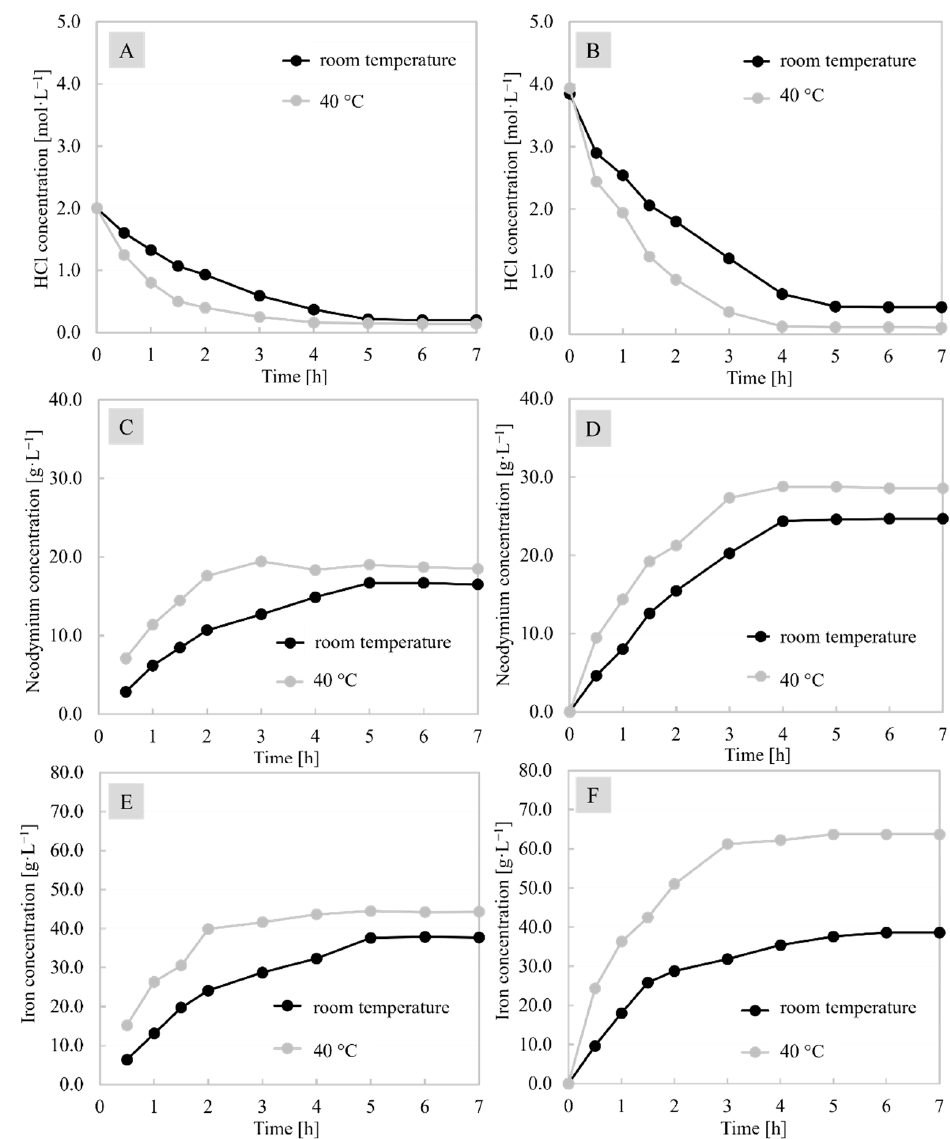
Figure 6. Leaching of demagnetized and broken NdFeB magnets in 2 M HCl solution (left side) and 4 M HCl solution (right side). Different figures show the dependence between leaching time and the concentration of HCl ( A , B ), neodymium ( C , D ) and iron ( E , F ).